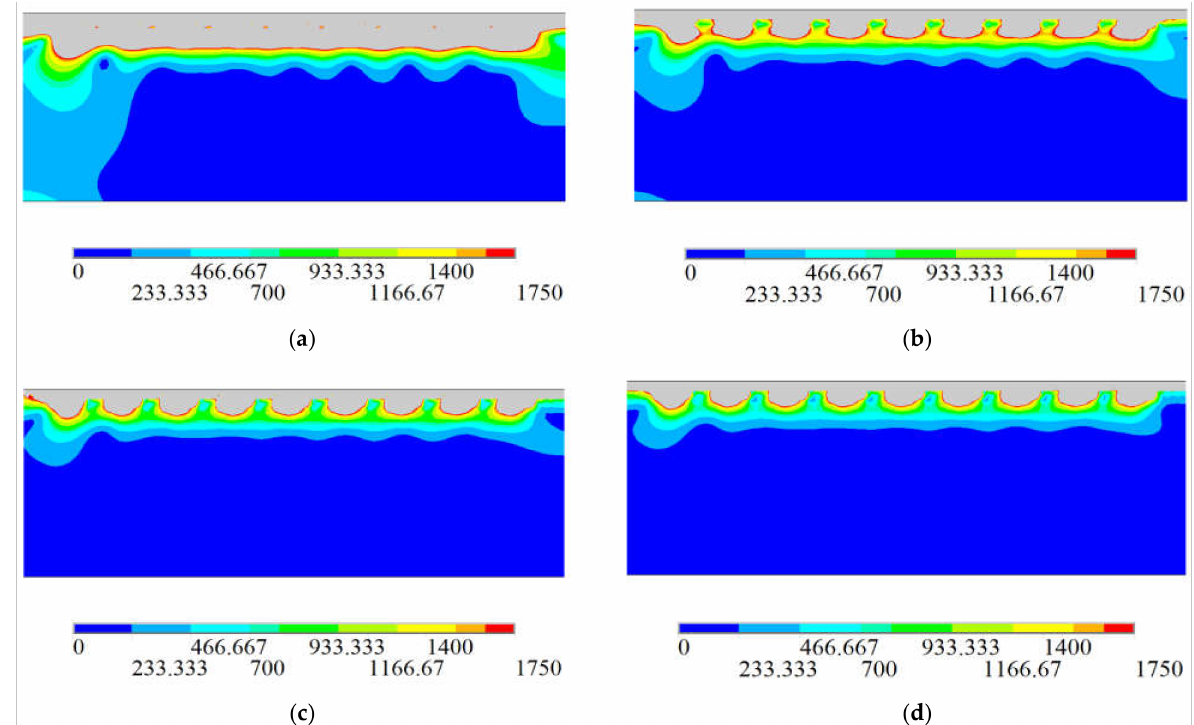
Figure 6. Optical fiber stress cloud diagram. ( a ) Coating one time; ( b ) Coating two times; ( c ) Coating three times; ( d ) Coating four times.